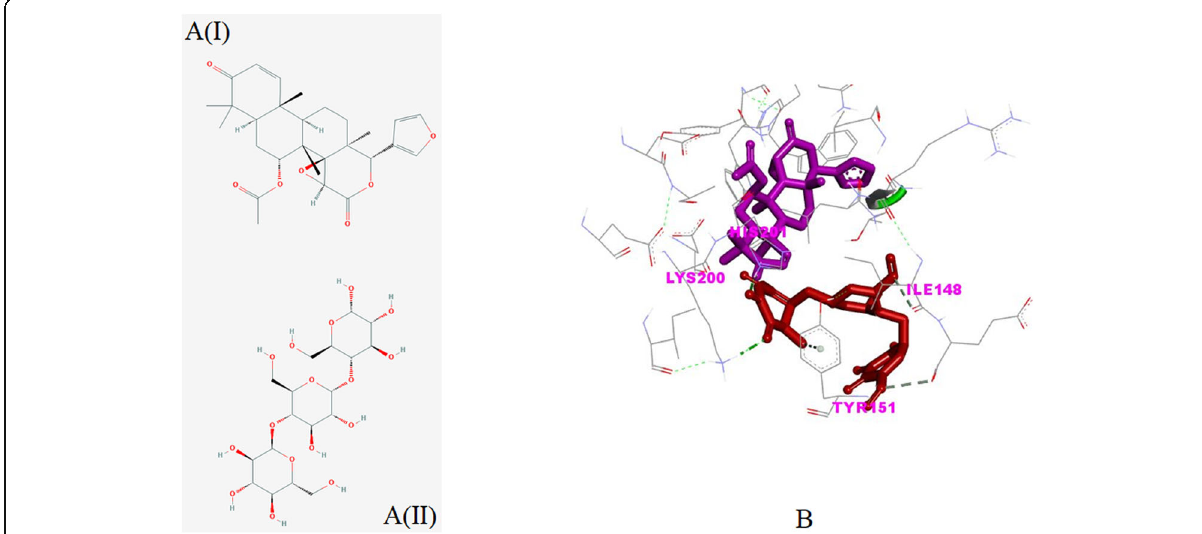
Fig. 3 Molecular docking simultaneous interaction pattern of amylose and gedunin with the active site of HPA (PDB ID: 1HNY) generated using AutoDock Tools 4.2 platform [ A(I) ] 2D structure of gedunin (PubChem CID: 12004512) [ A (II) ] 2D structure of amylose (PubChem CID: 192826) ( B ) 3D docking representation of simultaneously docked compounds (amylose- substrate in red and gedunin- inhibitor in magenta) in the binding pocket showing the hydrogen bond